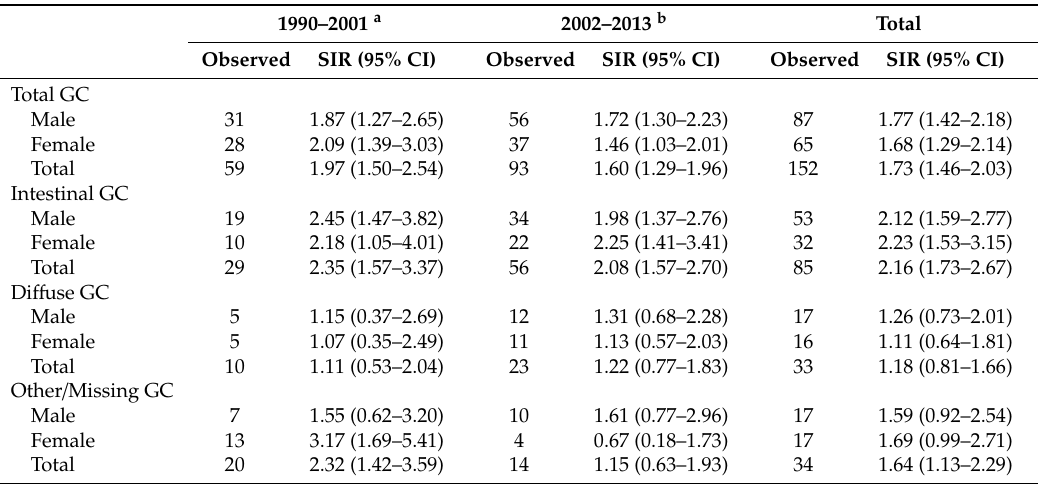
Table 4. Standardized incidence ratios for subtypes of gastric cancer among resettlers in comparison to the general population in Münster and